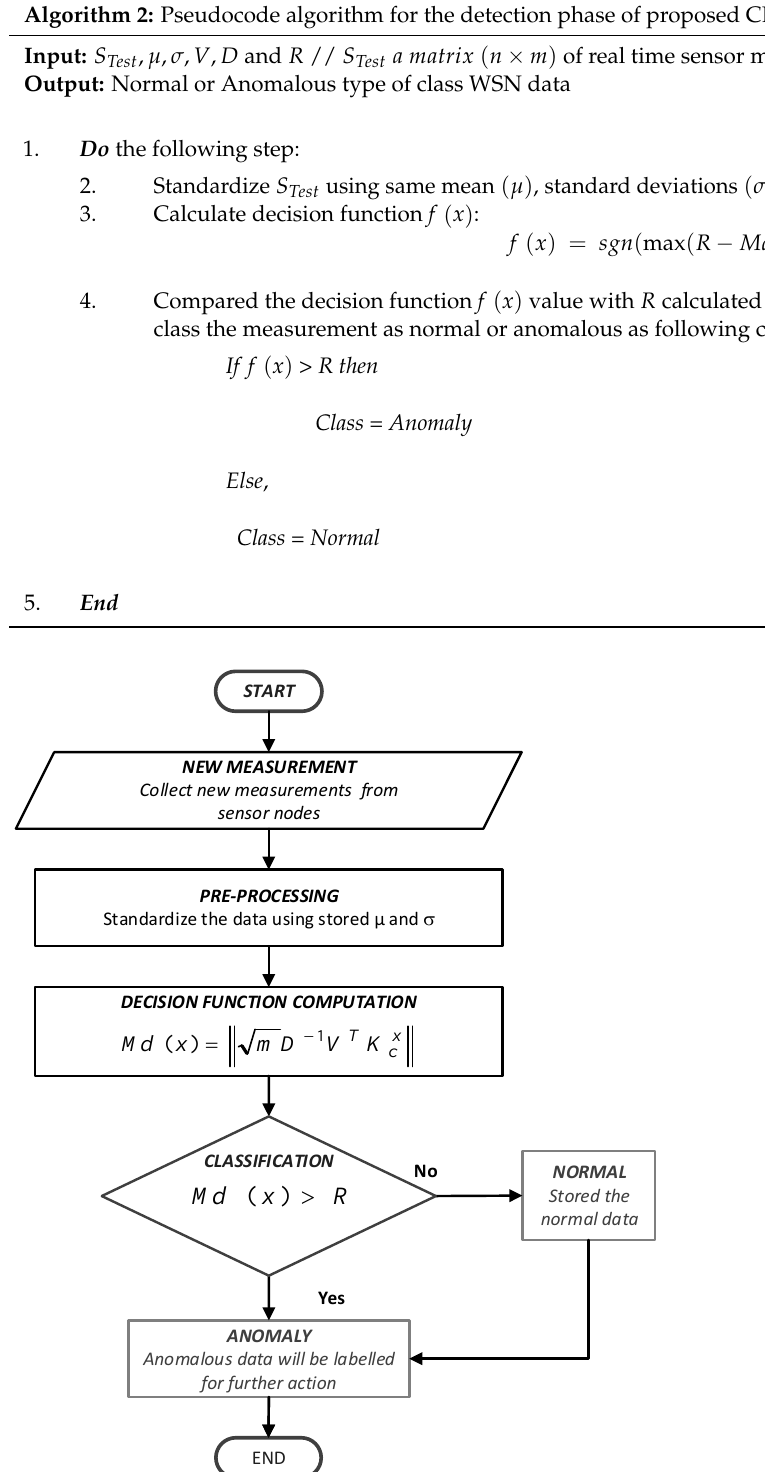
Figure 4 Figure 4. Flowchart for Detection Phase in the proposed CESVM-DR